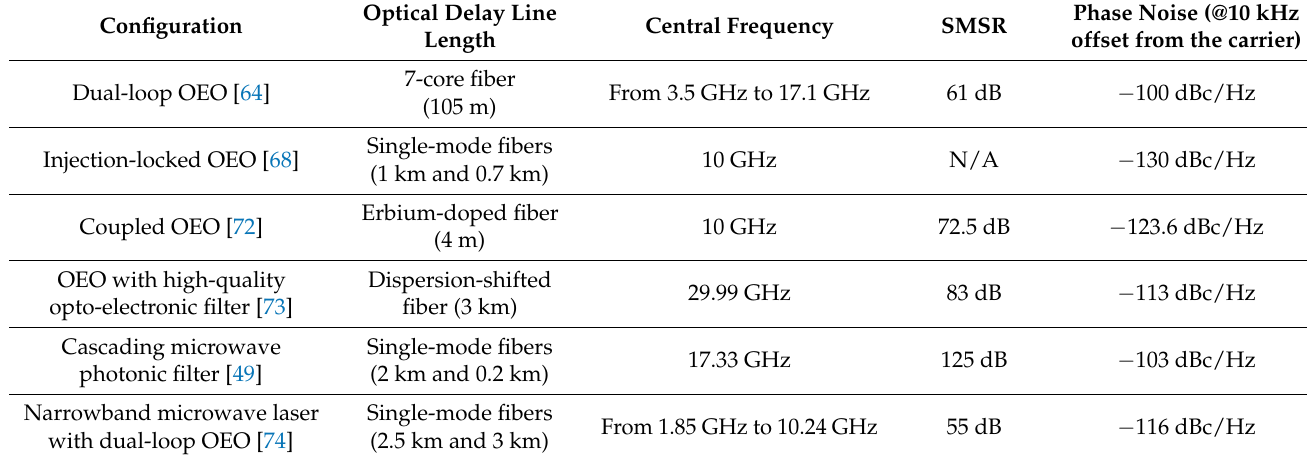
Table 1. Comparison of the SMSR and the phase noise of the current results for various advanced configurations of the OEO.